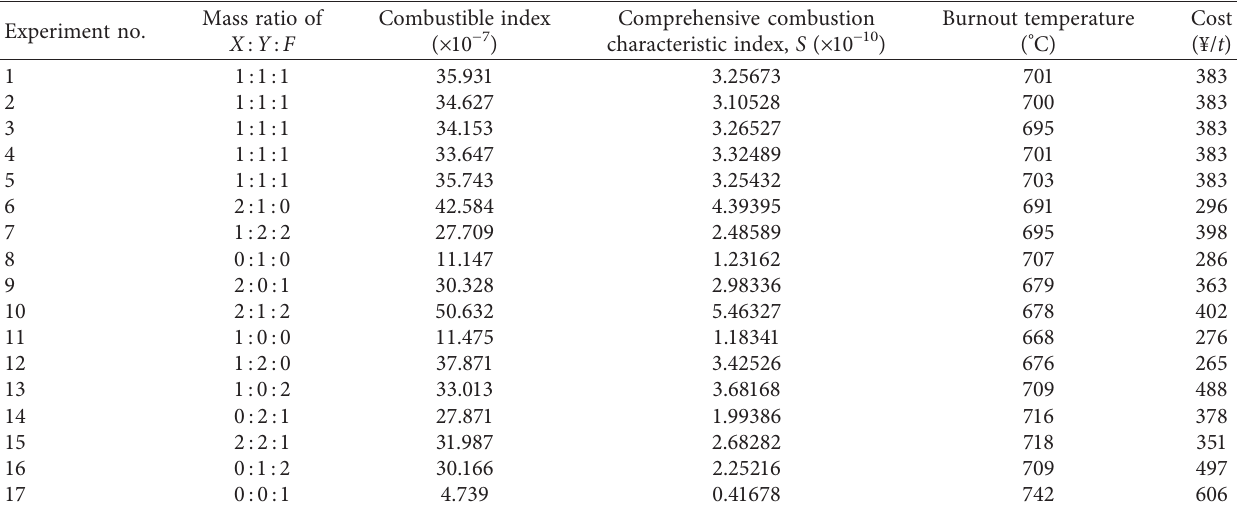
Table 9: Design and results of Box-Behnken orthogonal experiment. Experiment